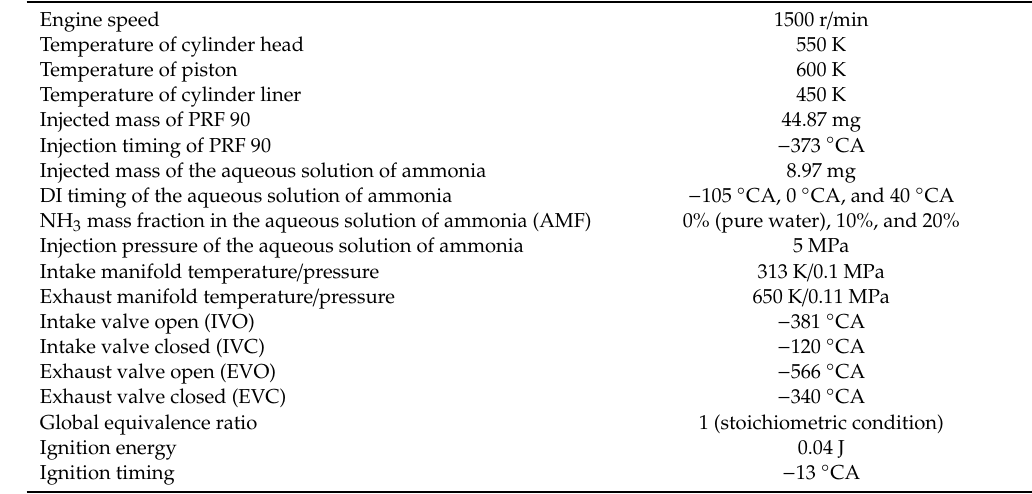
Table 2. Initial parameters and boundary conditions. DI, direct injection; PRF, primary reference fuel; AMF, ammonia mass fraction.